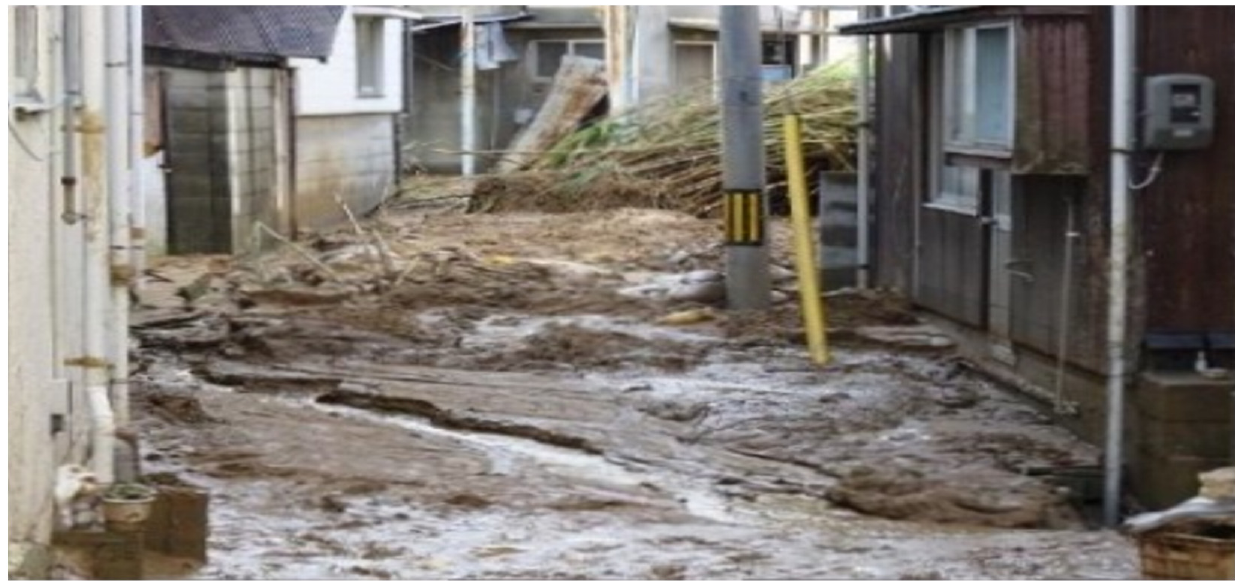
Figure 10. Debris flowed into a residential area in the Takahama district [51].